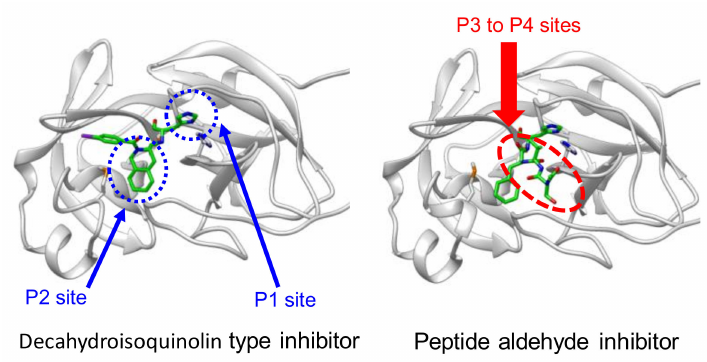
Figure 15. Comparison of the X-ray crystal structure of SARS-CoV 3CL pro complexed with decahydroisoquinoline-type inhibitor 42 (PDB code 4TWW) and the peptide aldehyde inhibitor 37 (PDB code